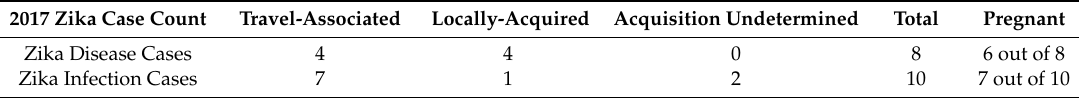
Figure 1. The line depicts a sharp increase in the number of Zika virus (ZIKV) specimens tested (noted as a blue line) and non-negative results (noted as red bars), after the 2017 Zika virus Health Alert was released. A total of 14,614 labs were processed, resulting in 150 non-negative samples. Non-negative samples included results that were positive, equivocal, indeterminate, or other results that were not negative. Testing peaked in August 2017, with 26 non-negative samples and 2036 negative samples. Table 3. This table presents the breakdown of cases that were symptomatic disease cases versus asymptomatic infections. Acquisition was also determined, with 5 cases identified as locally- acquired. The majority of cases were pregnant with 75% pregnant symptomatic disease cases and 70% asymptomatic infection cases.